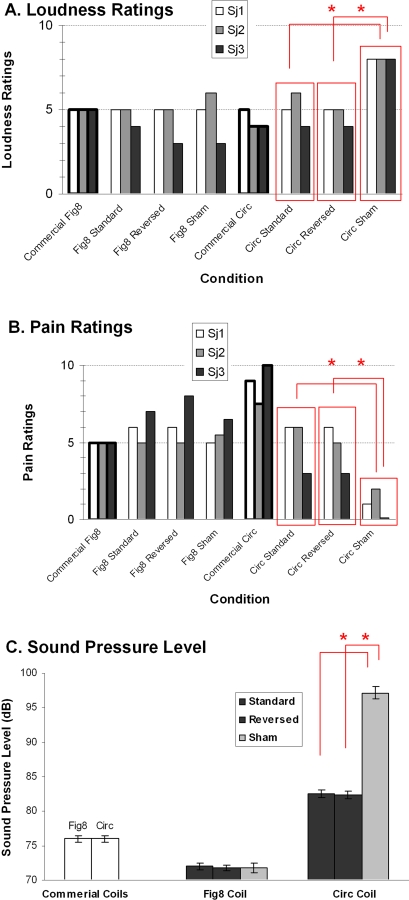
Loudness and Pain Sensation and Sound Levels.Subjective ratings for loudness (A) and for pain (B) from three naïve subjects for the three stimulus types. Stimulator was set at 90%. Ratings for stimuli from commercially available coils are included as reference. (C) Maximum sound pressure levels of the same stimuli. Error bars represent standard error of the mean. Comparisons with significant difference are marked with asterisks.